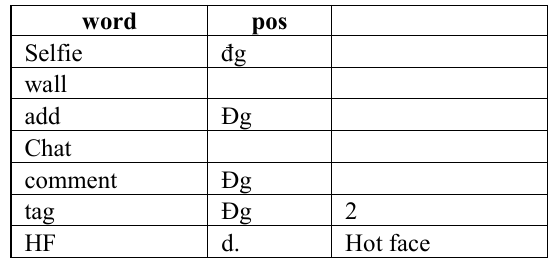
Table 2. Some notional words extracted from corpus